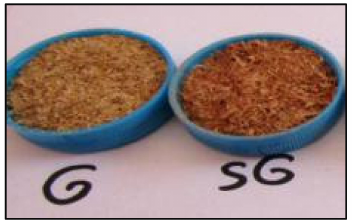
Figure 4. Biomass of rice husk (G) and sawdust